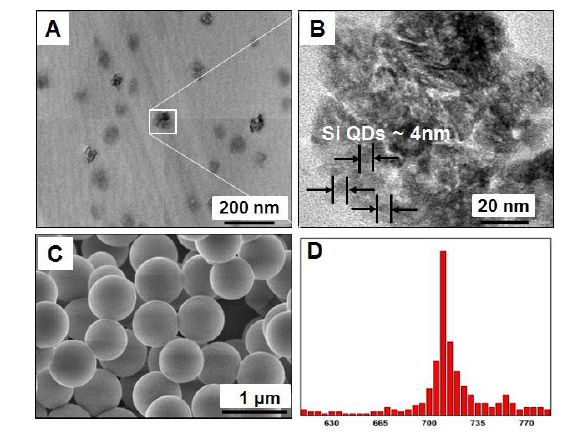
Fig. 2. TEM micrographs of Si QDs at lower magnification (A) and higher magnification (B). SEM image of Si/SiO 2 spheres (C) and their size distribution (D). The Si-O linkage from the Si QDs particles plays a seed role for the growth of the SiO 2 thicker layer on the surface of the particles in the progress of Si/SiO 2 synthesis [26,33]. Figure 2C shows that the Si/SiO 2 colloids are mono-disperse in a spherical shape with homogenous size. Their size distribution is concentrated at 720 nm with a very narrow deviation (Figure 2D). This submicron size is close to the size of the silica clusters accumulated on the surface of the marine diatom in